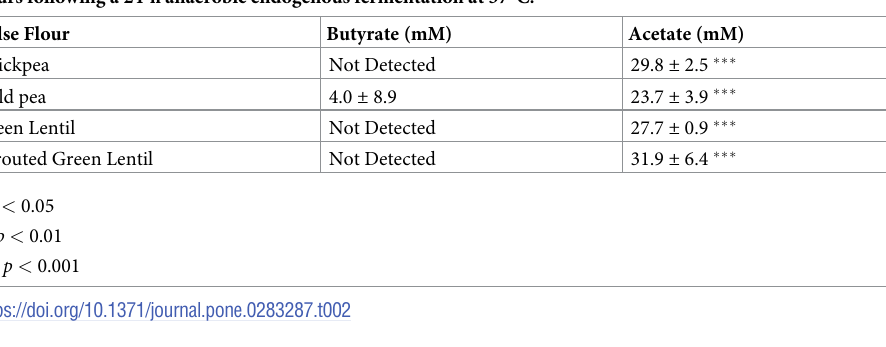
Table 2. Butyrate and acetate concentrations produced by endogenous pulse flour microbes in untreated pulse flours following a 24-h anaerobic endogenous fermentation at